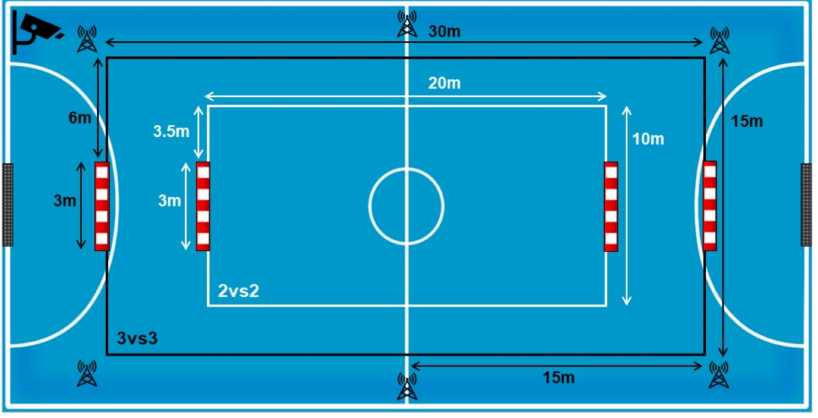
Figure 2. Pitch size and camera